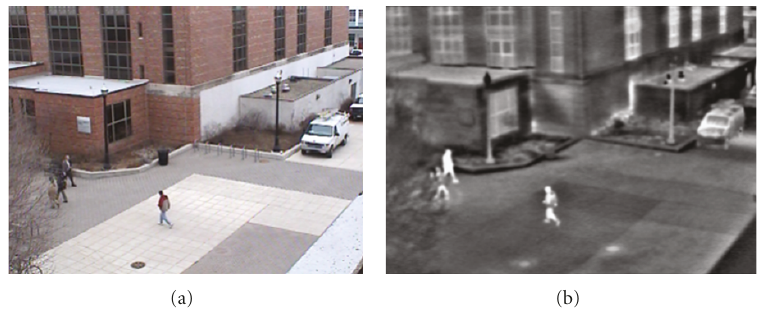
Figure 6: A color image (a) and a thermal image (b) from OSU Color-Thermal Database [17, 105].